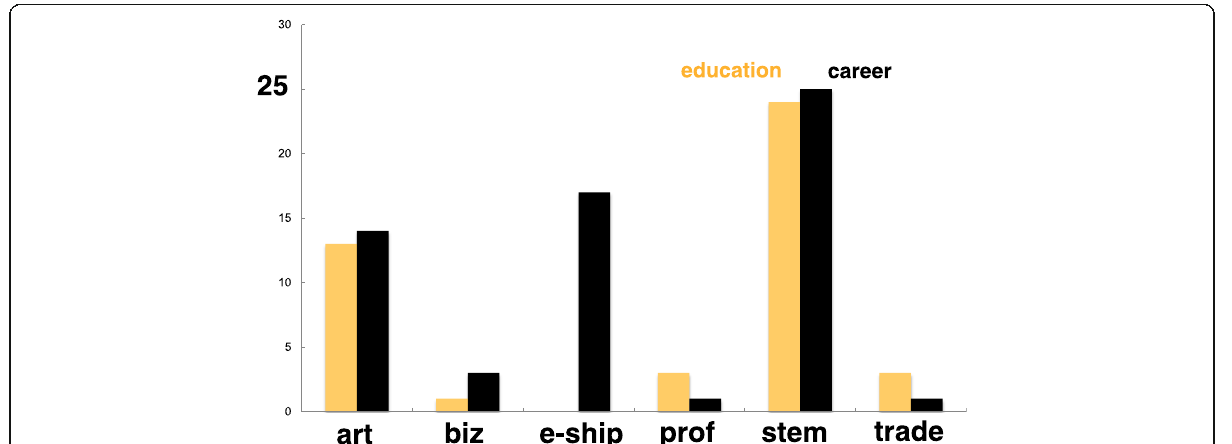
Fig. 2 Educational backgrounds and careers of the Maker participants (consolidated